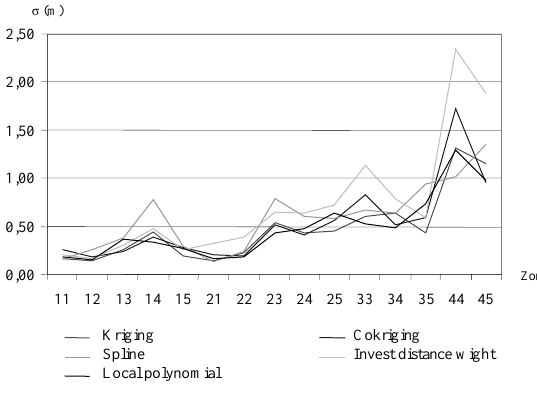
Fig 10. Diagram of standard deviations of DEM in different